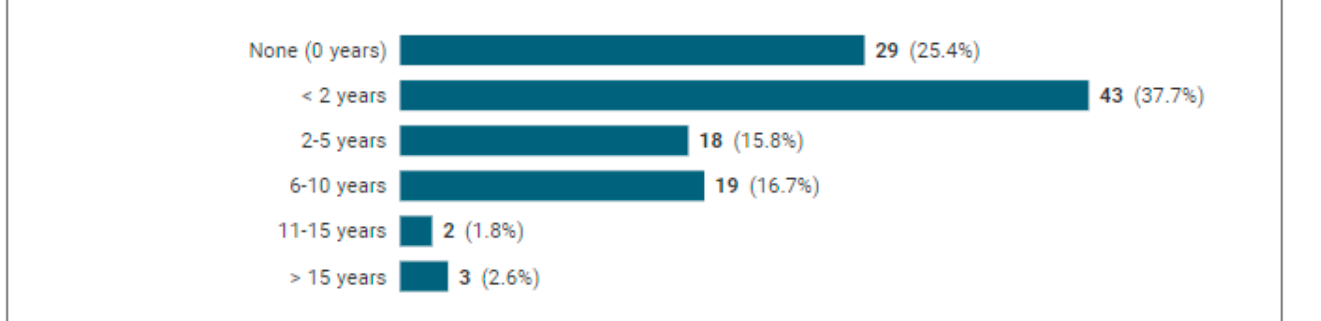
Figure 2. Years of implementing BIM and GIS in an integrated way.